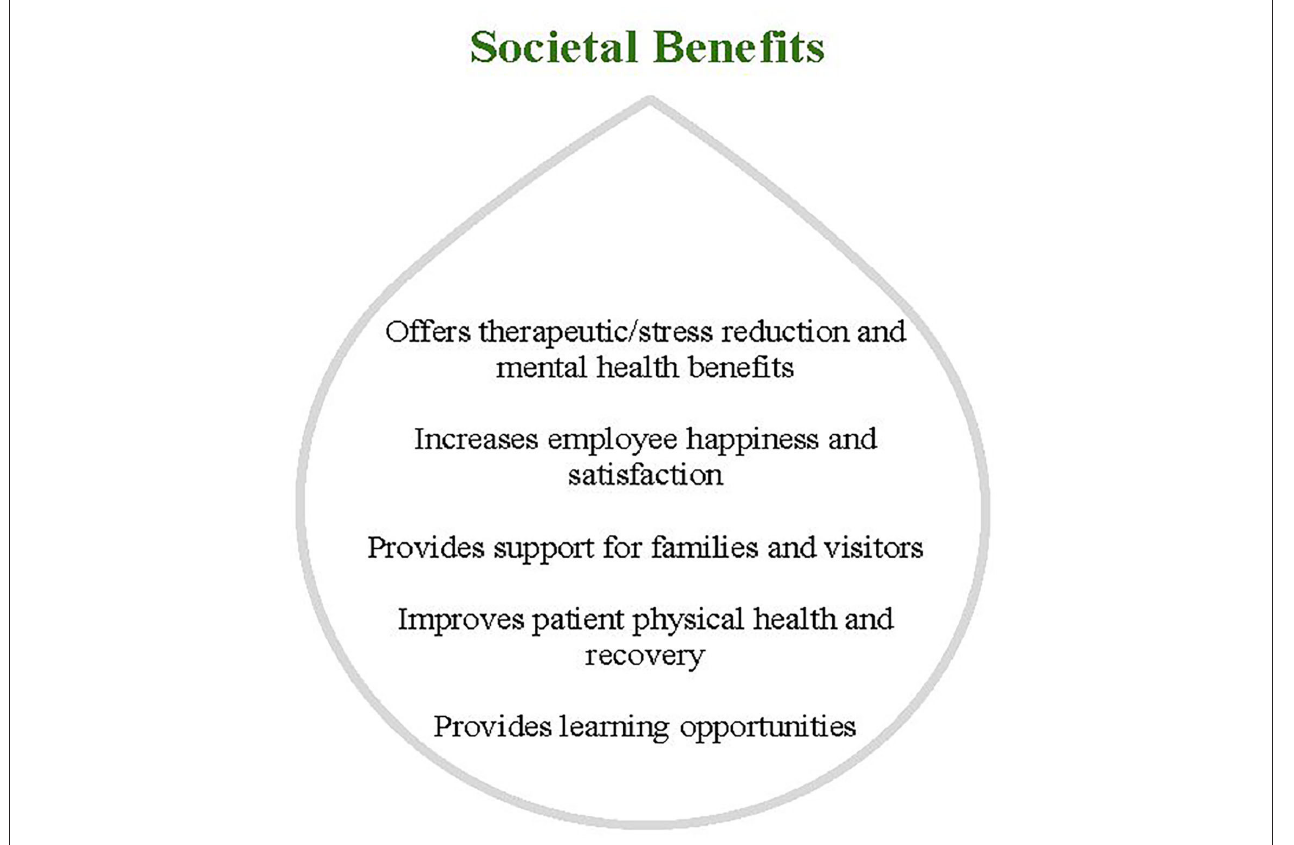
FIGURE 3 | Summary of societal benefits for green roofs on